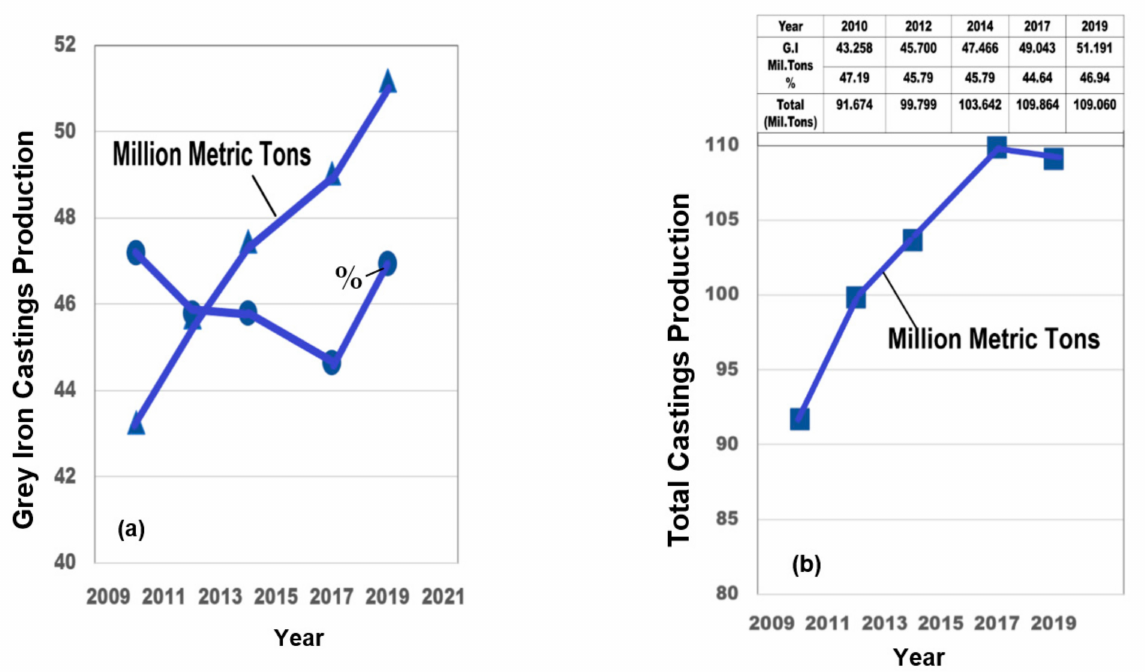
Figure 2. Evolution of grey (lamellar graphite) cast iron production ( a ) reported in the context of total world metal-casting production (2009–2019) ( b